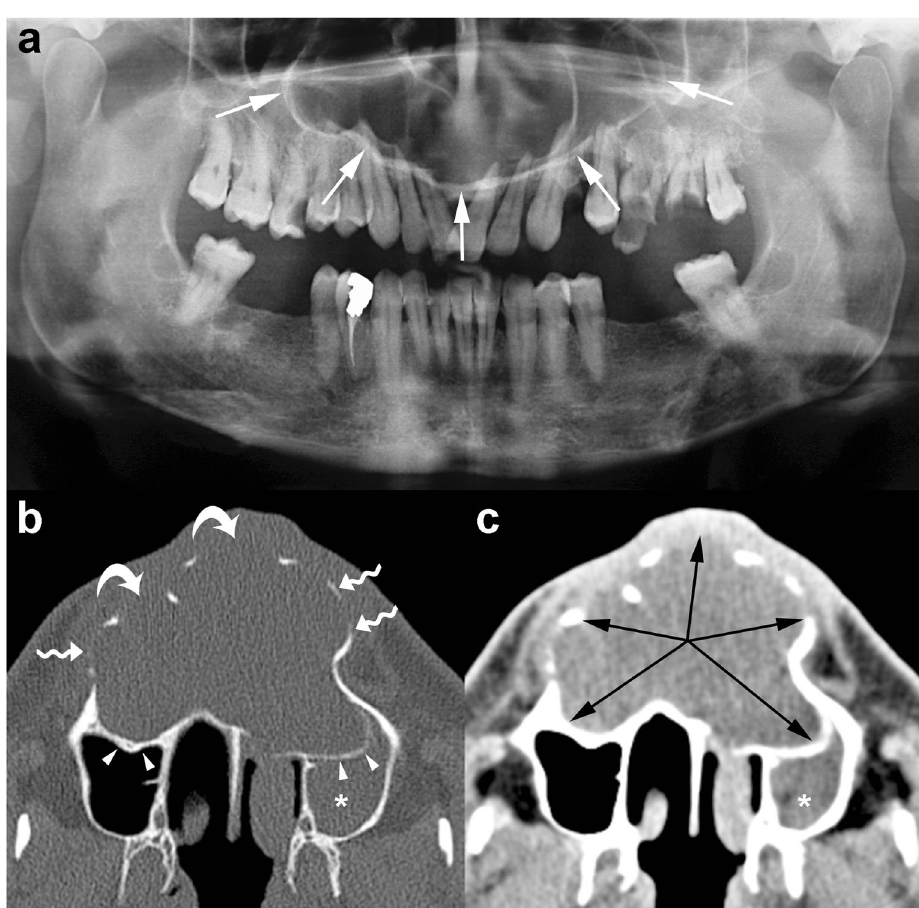
Fig. 5 Maxillary OKC. Panoramic radiograph ( a ) showsa large radiolucency with a well- defined and corticated rim in the maxilla ( white arrows ). Axial multidetector computed tomography (MDCT) images with bone window ( b ) and soft tissue window ( c ) clearly demonstrate the hydraulic expansion of the maxillary alveolar bone ( black arrows ) with thinning ( wavy arrows ) and perforation ( curved arrows ) of the buccal cortex. Posterior bowing of the floor of the maxillary sinuses ( arrowheads ) and inflammatory material within the left maxillary sinus ( asterisks ) are also